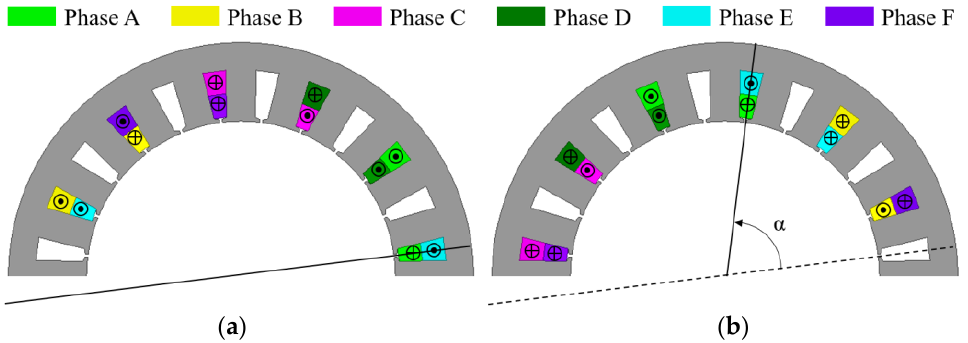
Figure 4. Design of ( a ) first and ( b ) second set of the 12-slot/10-pole winding layout.